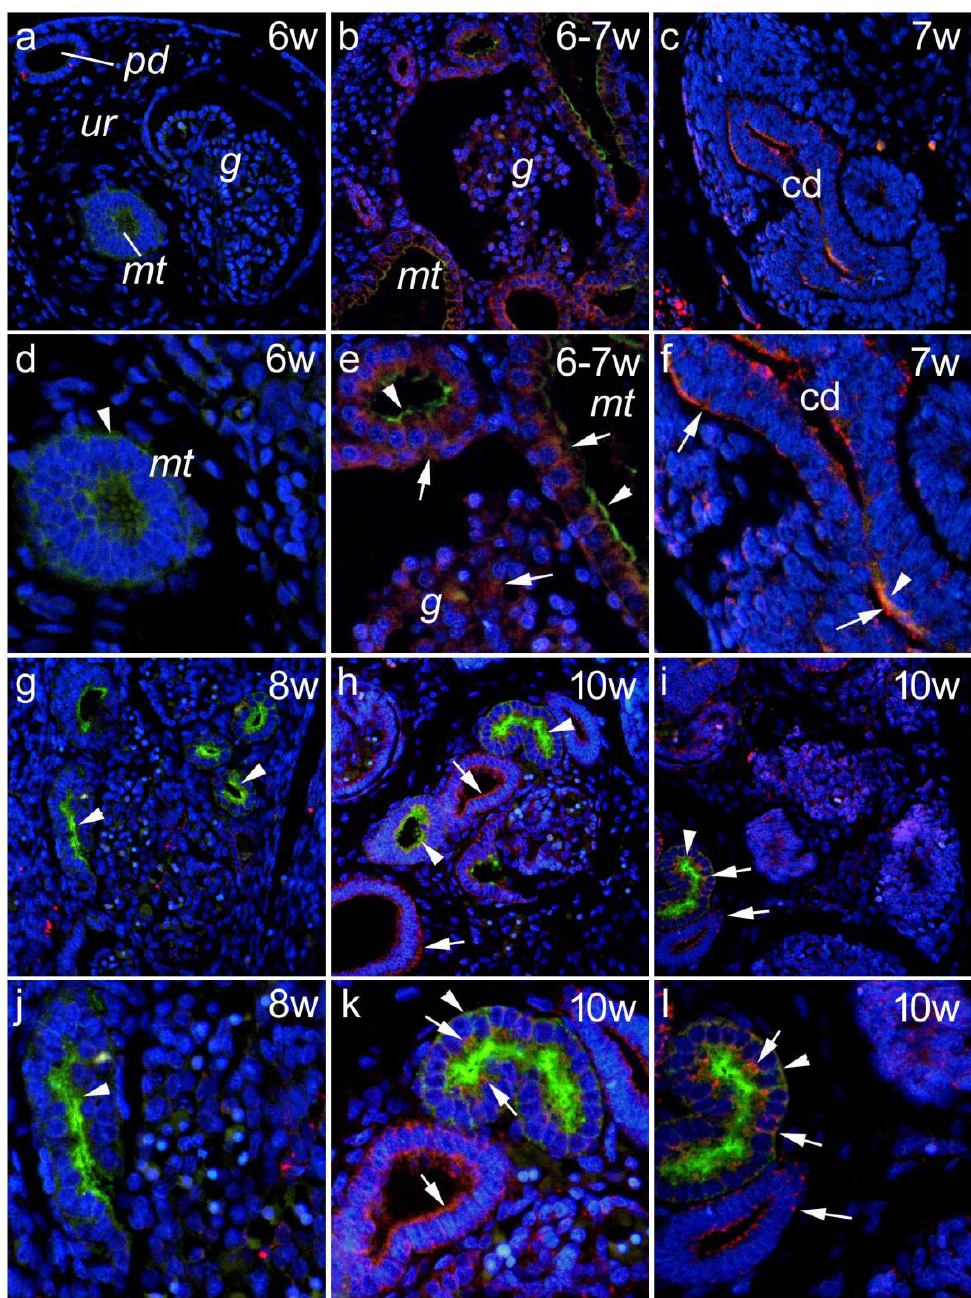
Figure 3. Lotus tetragonolobus lectin (LTL) binding during embryonic and early fetal development